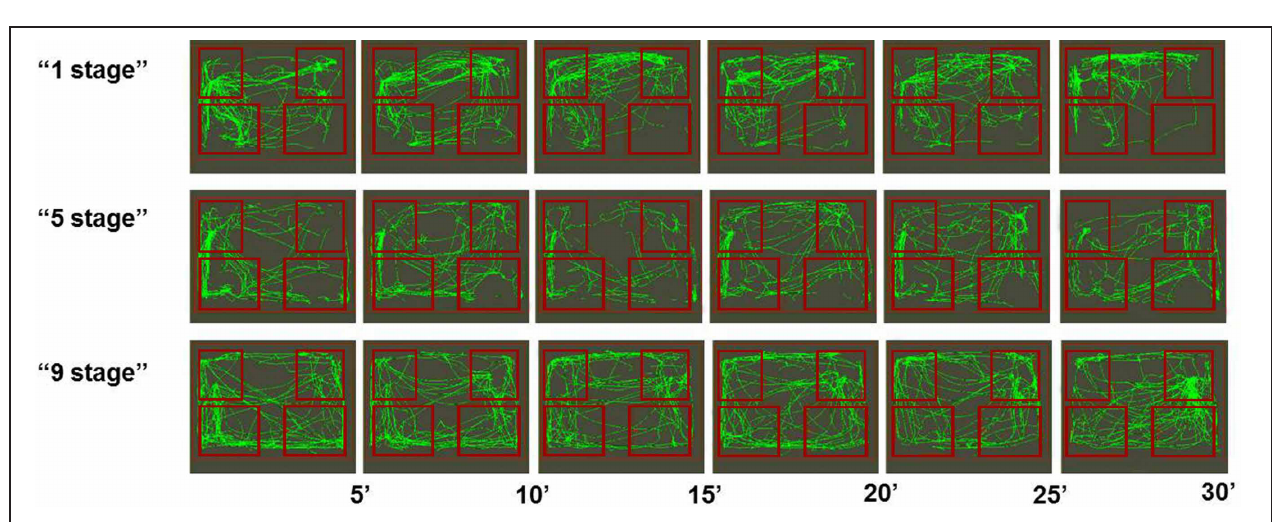
FIGURE 4 | Movement paths of representative rats (from all three groups) that did not learned Task 2 successfully. Rectangles represent feeder zones (at the top) and bar zones (at the bottom). Rewarded locations